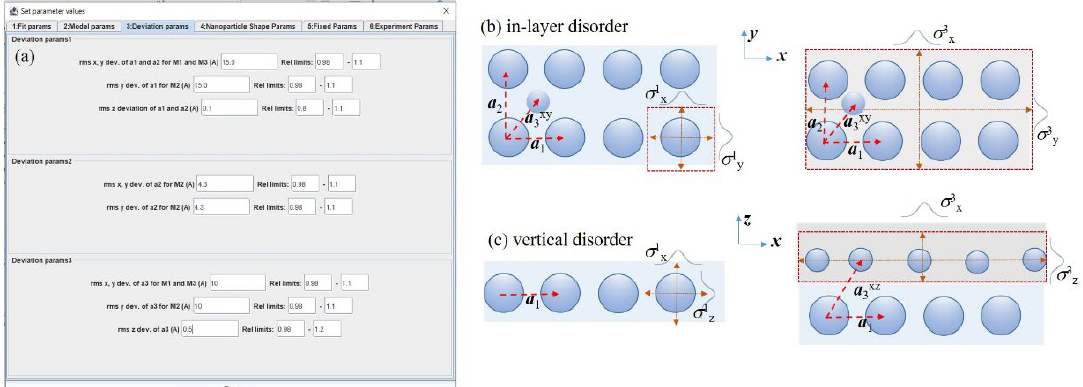
Figure 7. ( a ) Tab Deviation params with the corresponding parameters. ( b ) Illustration of disorder parameters σ 1,2,3xy . The disorder properties within each layer parallel to the surface ( σ 1,2xy ) are usually the same (left), and they describe the deviations of each NP within a layer from the ideal positions . The parameters σ 3xy (right) describe the disorder of each layer from the ideal position, and therefore, are a measure of the quality of the self-assembly process that leads to formation of the 3D NP lattice. ( c ) The disorder parameters in the vertical direction (perpendicular to the surface). These parameters describe the deviation of each NP within a layer ( σ 1,2 z ), and of each layer ( σ 3 z ) from the ideal positions in the vertical ( z ) direction.